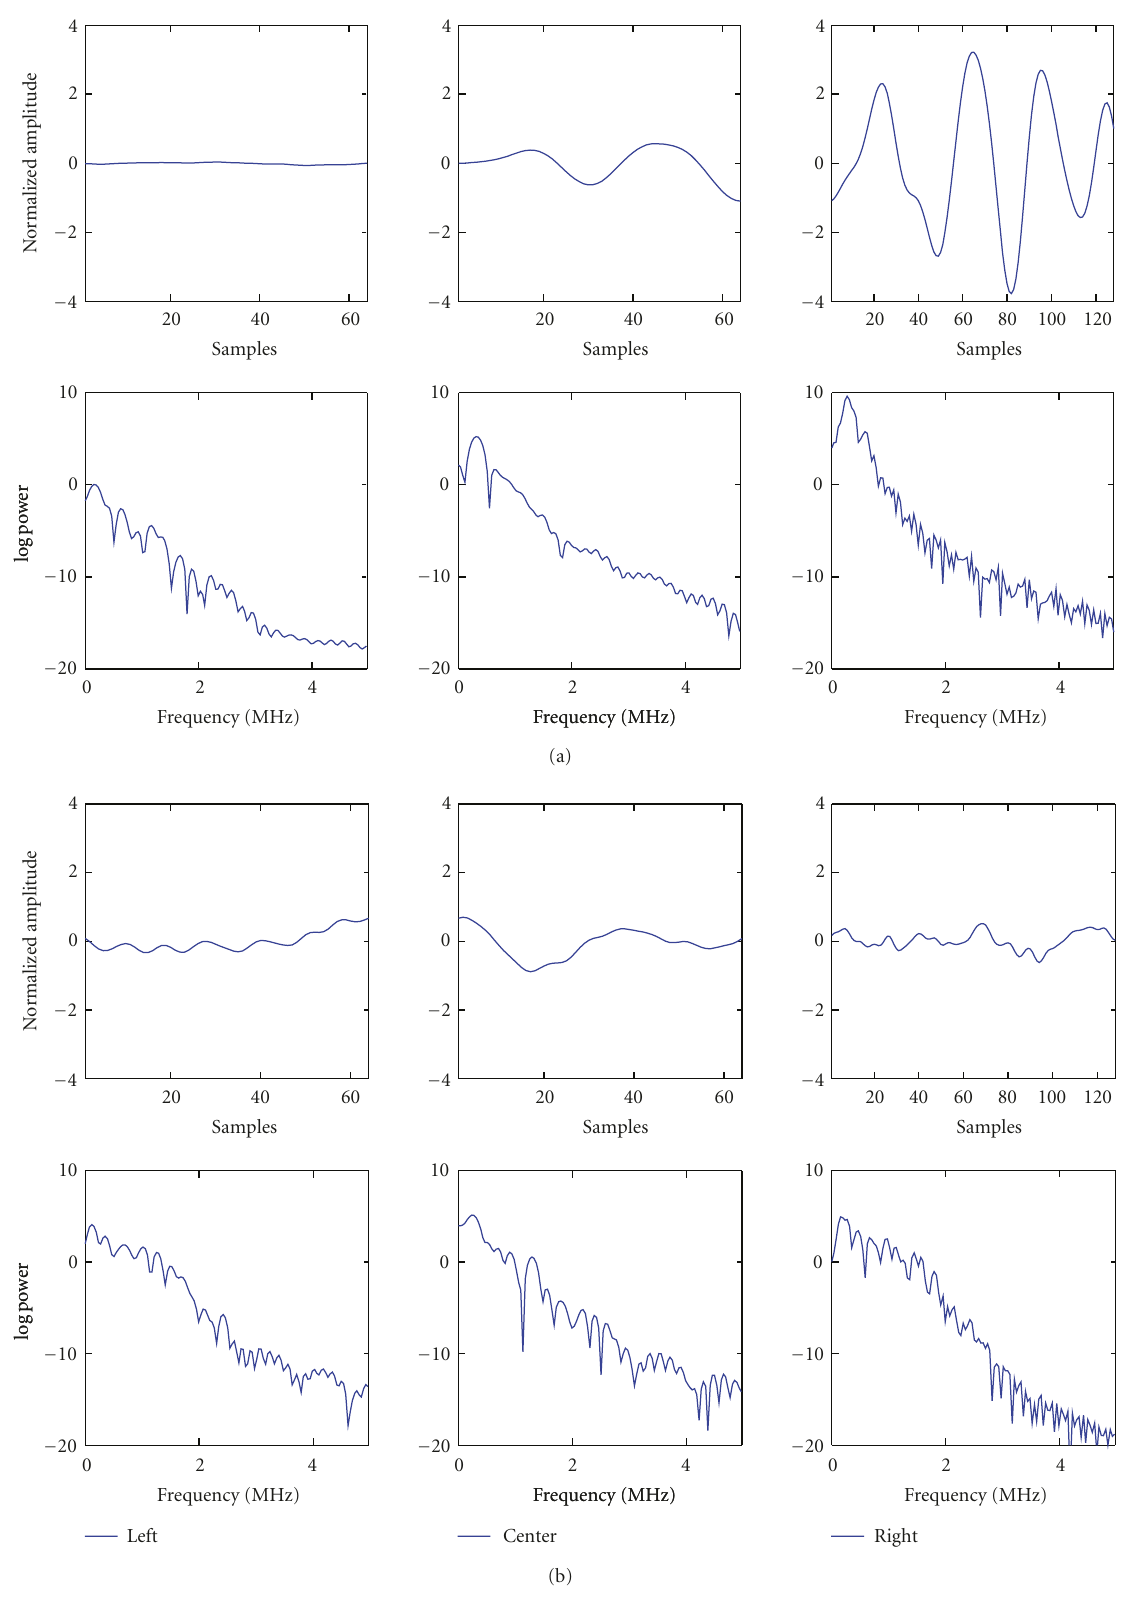
Figure 6: (a) Waveforms and log power spectra of 64-sample long time window preceding the P-wave, centered around P-wave, and a 128- sample long window after the P-wave; (b) Raw data and spectra of noise segments that may be recognized as a